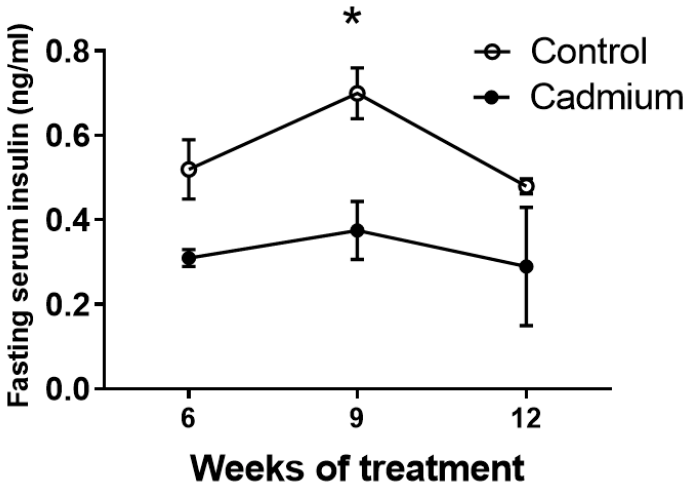
Figure 2. Serum samples were taken from 5 h fasted animals at 6, 9, and 12 weeks of Cd treatment (0.6 mg/kg/day). An asterisk (*) denotes significant differences from week ‐ matched control values (one ‐ way ANOVA and Tukey’s post tests, p ≤ 0.05, n = 3 for each data